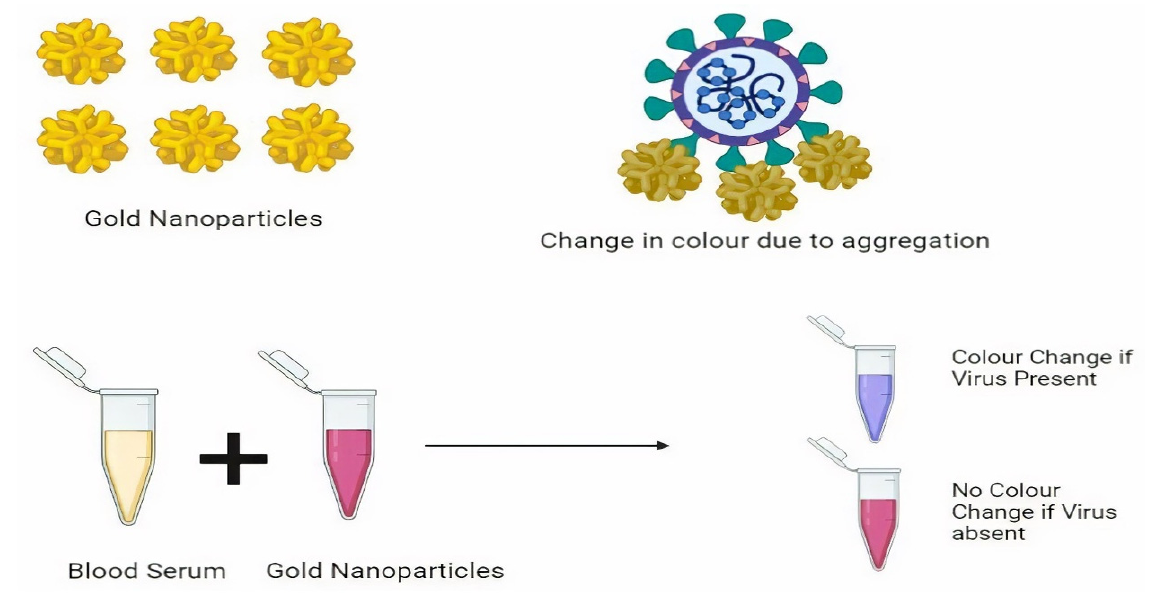
Figure 3. Nanoparticle-based virus detection using calorimetric assay.